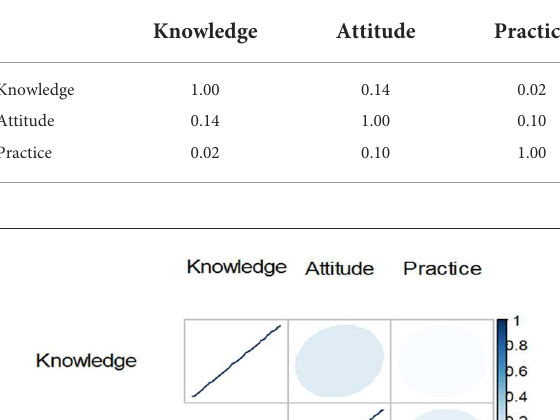
FIGURE6 Correlation between knowledge, attitude, and practice.